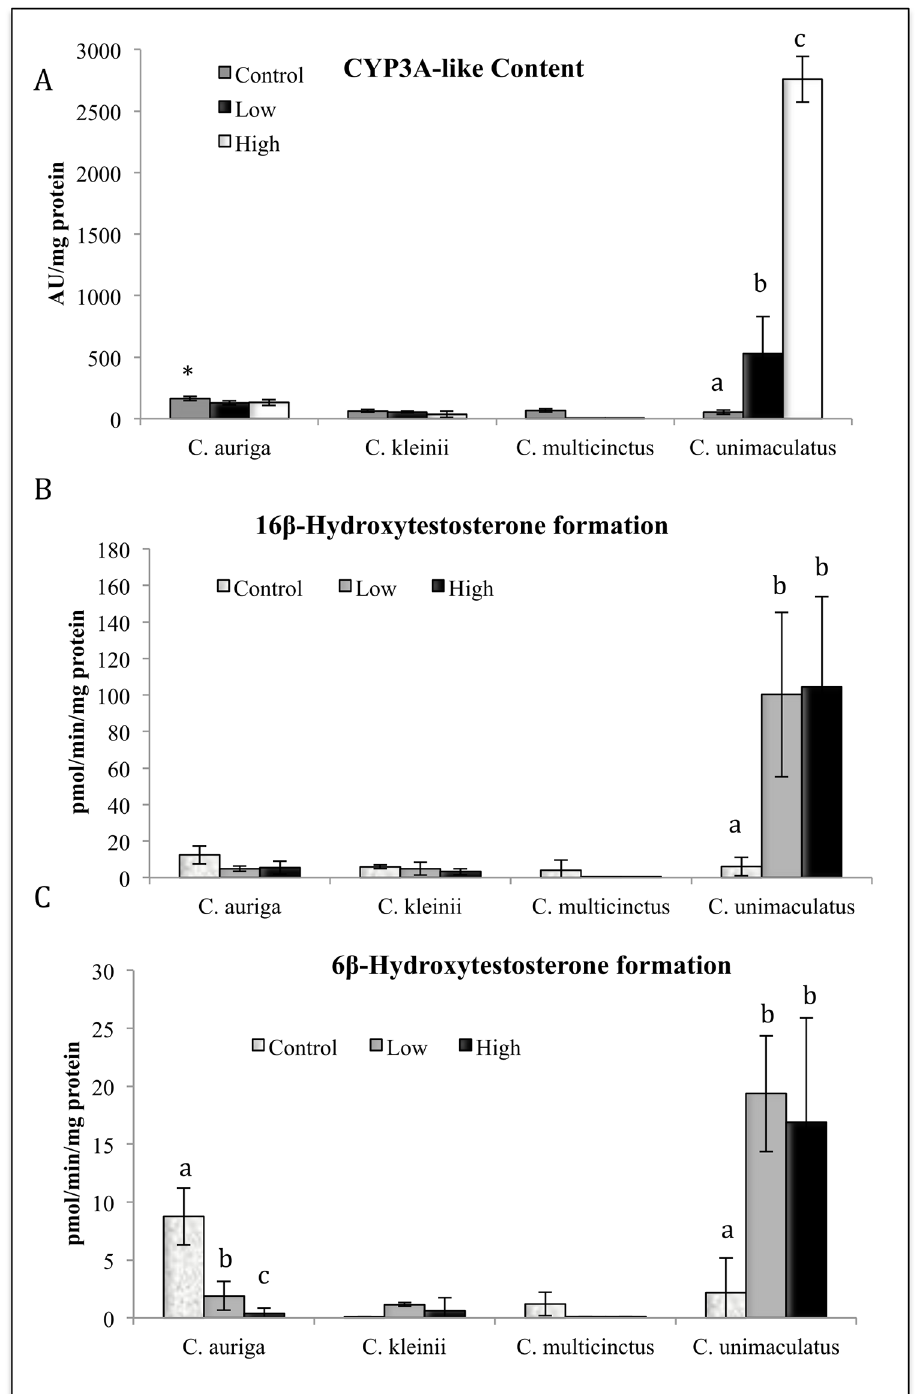
Fig 4. Effects of dietary exposure to 5ESL on the hepatic content (A) and catalytic activity (B, C) of and CYP3A in four species of butterflyfish. Different letters indicate significant (P (cid:1) 0.05) differences between untreated and treated fish (N = 6 –